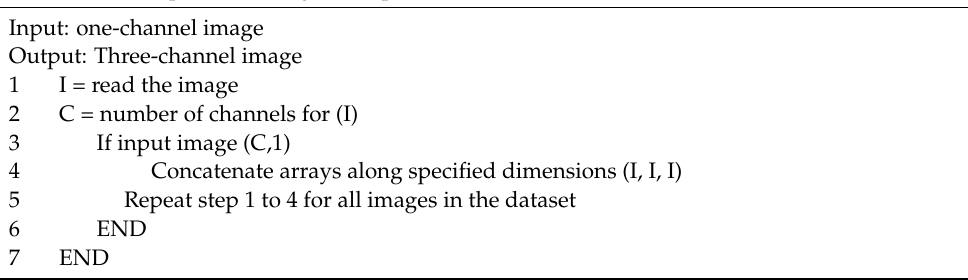
Algorithm 1 Duplication image for input